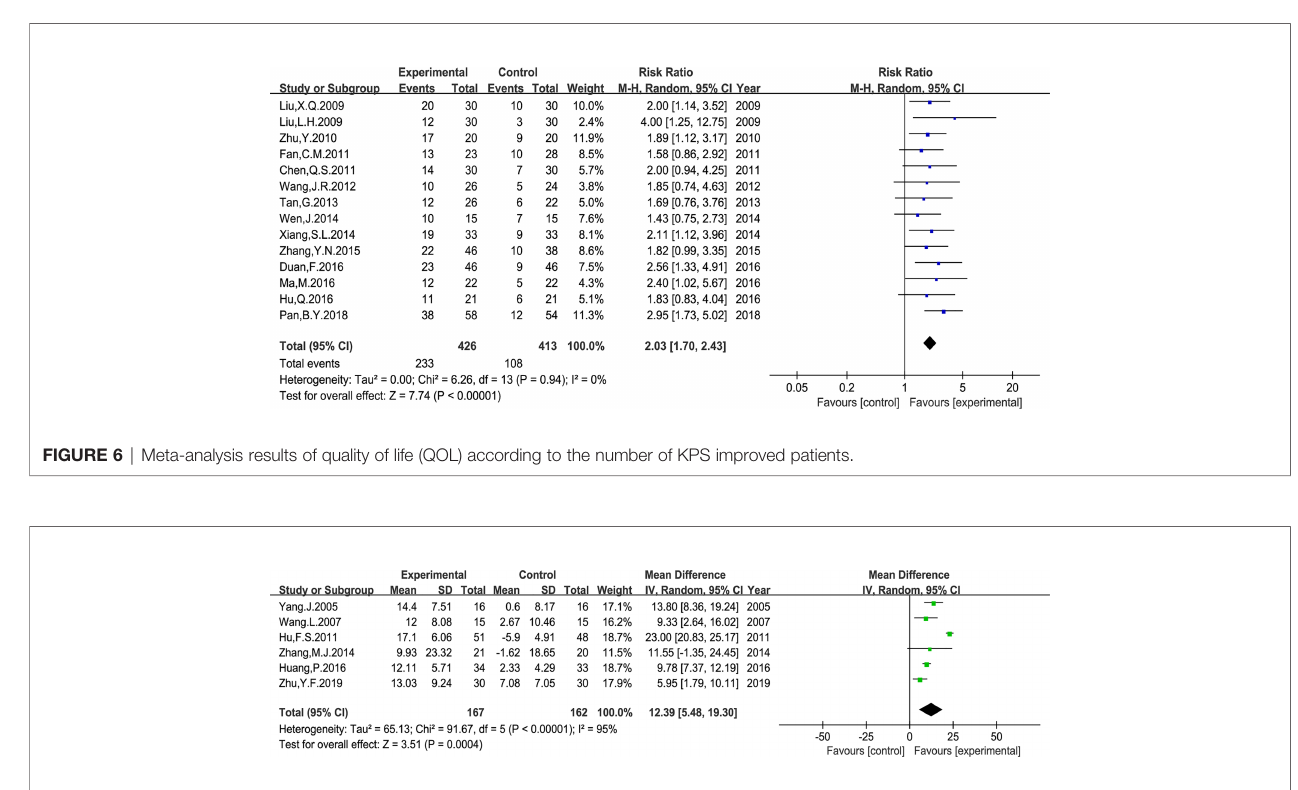
FIGURE 7 | Meta-analysis results of QOL according to mean ± SD.